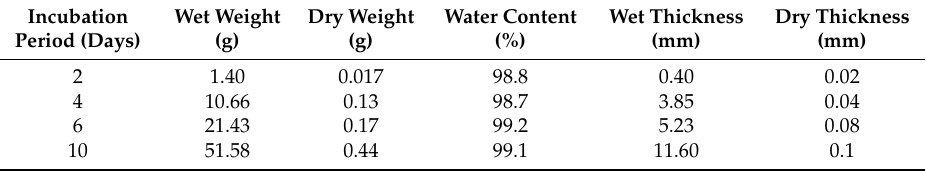
Figure 3. Photos show thickness of never-dried BC harvested after ( a ) 2 days, ( b ) 6 days and ( c ) 10 days. Table 1. Weight, thickness and water content of BC harvested after different incubation times.